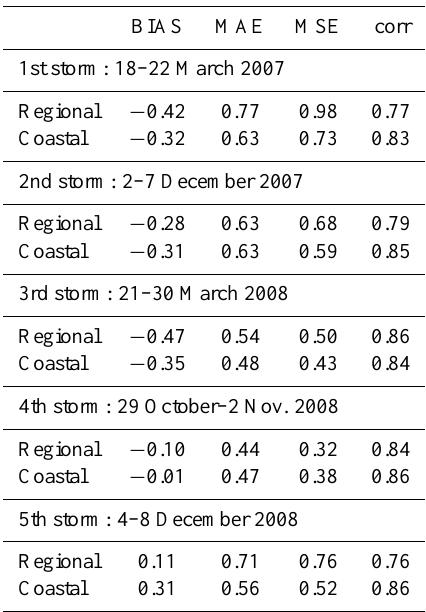
Table 1. Statistical results for the Carrara storm events